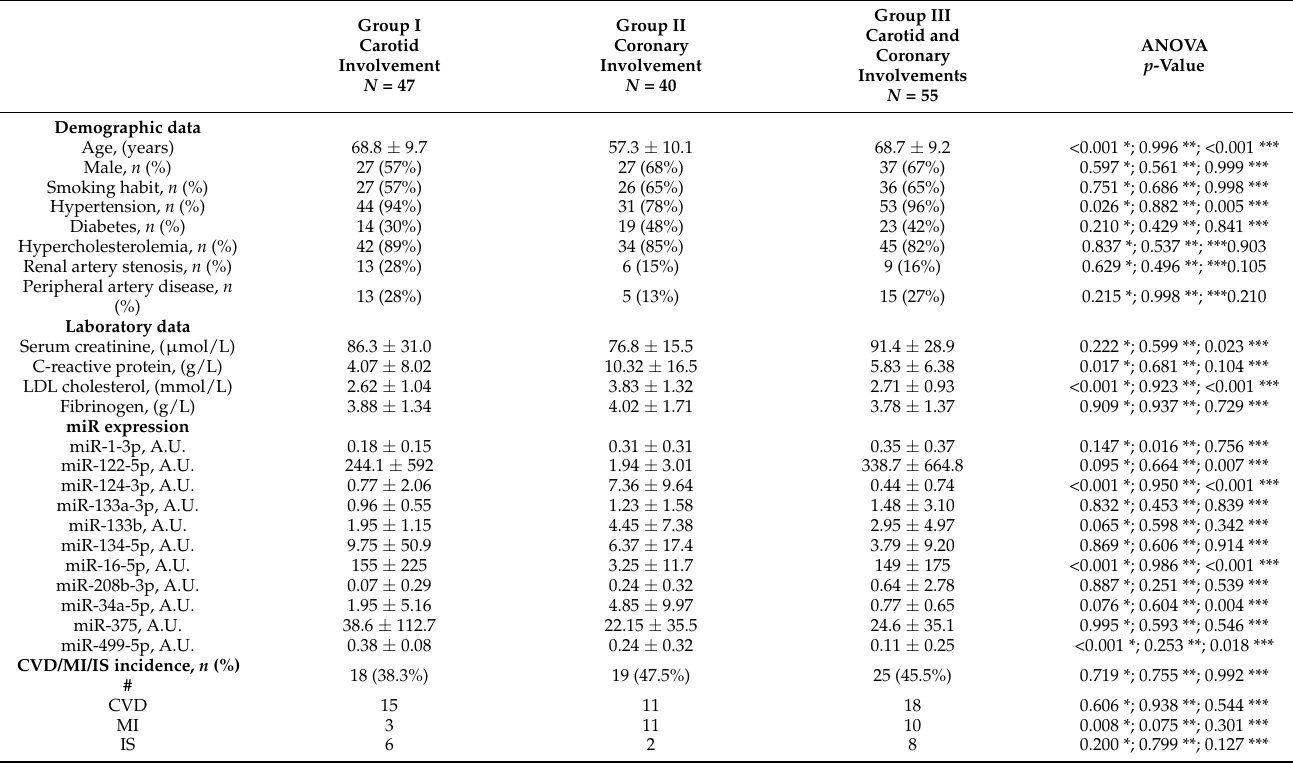
Table 1. Study group